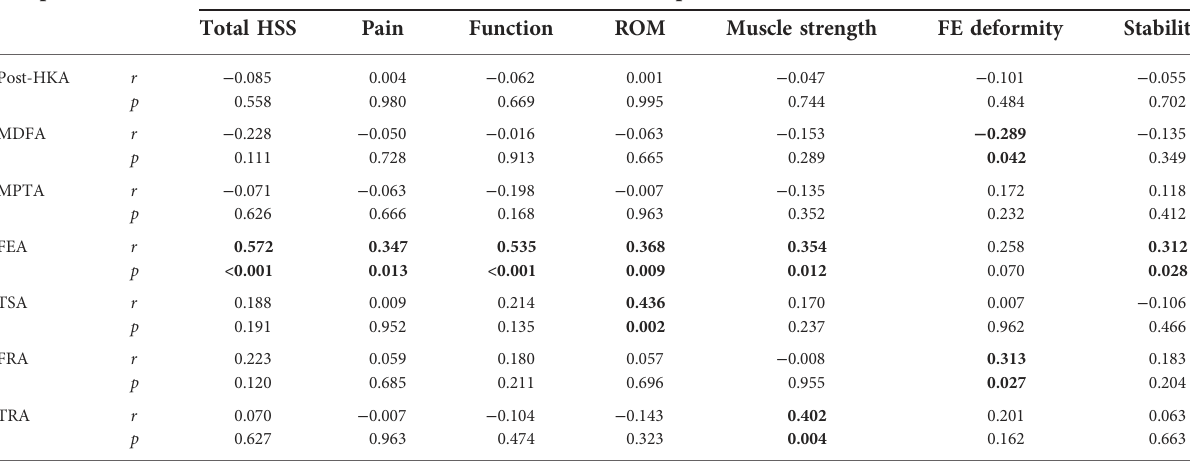
TABLE 4 Results of correlation analysis between alignments and clinical scores. Independent